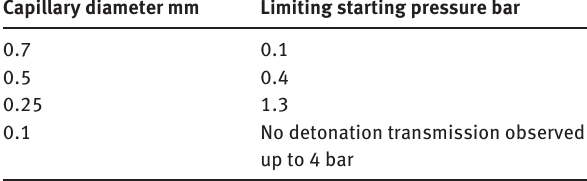
Table 1 Dependence of the ‘ limiting starting pressure ’ from capillary diameter for stoichiometric (equivalence ratio = 1) ethane/ oxygen mixtures.